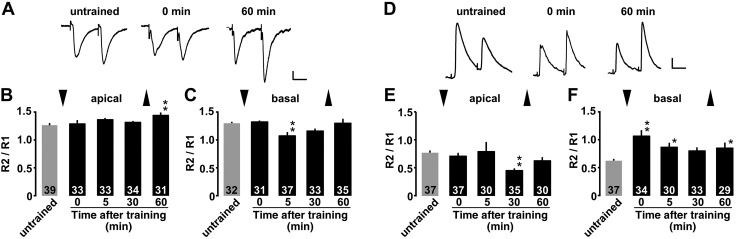
Presynaptic glutamate and GABA release probability. A) Representative traces of AMPA receptor–mediated paired-pulse responses at apical dendrites of CA1. B, C) Mean ratio at the apical (B) or basal dendrites (C) in untrained and trained rats. D) Representative traces of GABAA receptor–mediated paired-pulse response at basal dendrites of CA1. E, F) Mean ratio at the apical (E) or basal dendrites (F) in untrained and trained rats. Vertical bars = 20 pA; horizontal bars = 50 ms. *P < 0.05, **P < 0.01 vs. untrained. The number of neurons is shown at the bottom of each bar. Error bars indicate ± sem. ▼ and ▲ indicate the timing of training and retrieval tests, respectively.